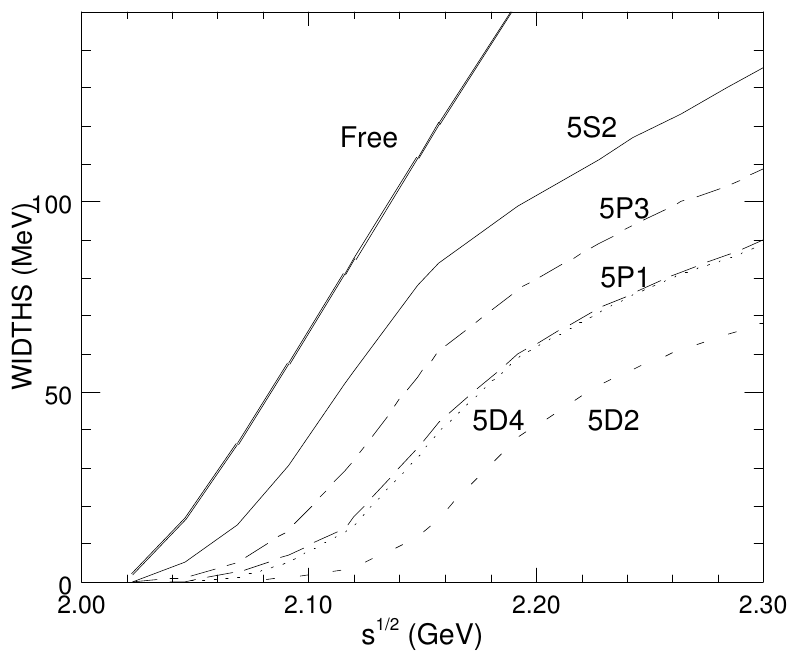
Figure 2. The widths of a representative selection of N ∆ states in NN scattering: Curves as described in the text. The free width is the thick line above the